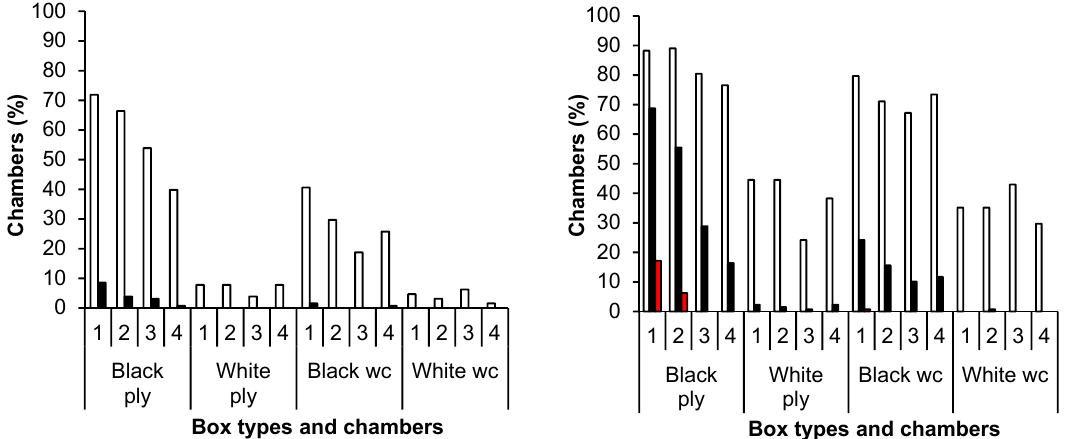
Figure 5. Percentage of chambers where chamber temperatures during T box_warmest (left) and T box_max (right) reached >30.0 °C (white bars), >35 °C (black bars) and >40 °C (red bars) during the 32-day monitoring period (5 February–8 March 2015). X-axis: 1 = front chamber; 2 = second chamber; 3 = third chamber; 4 = back chamber; ply = plywood; wc = wood-cement.